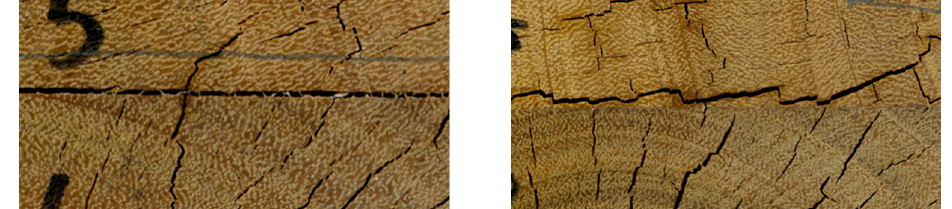
Figure 4. Delamination due to very shallow adhesive penetration ( left ) and wood fibre failure distant from the glue line ( right ) and not classified as delamination—due to deeper adhesive penetration in spotted gum glulam.